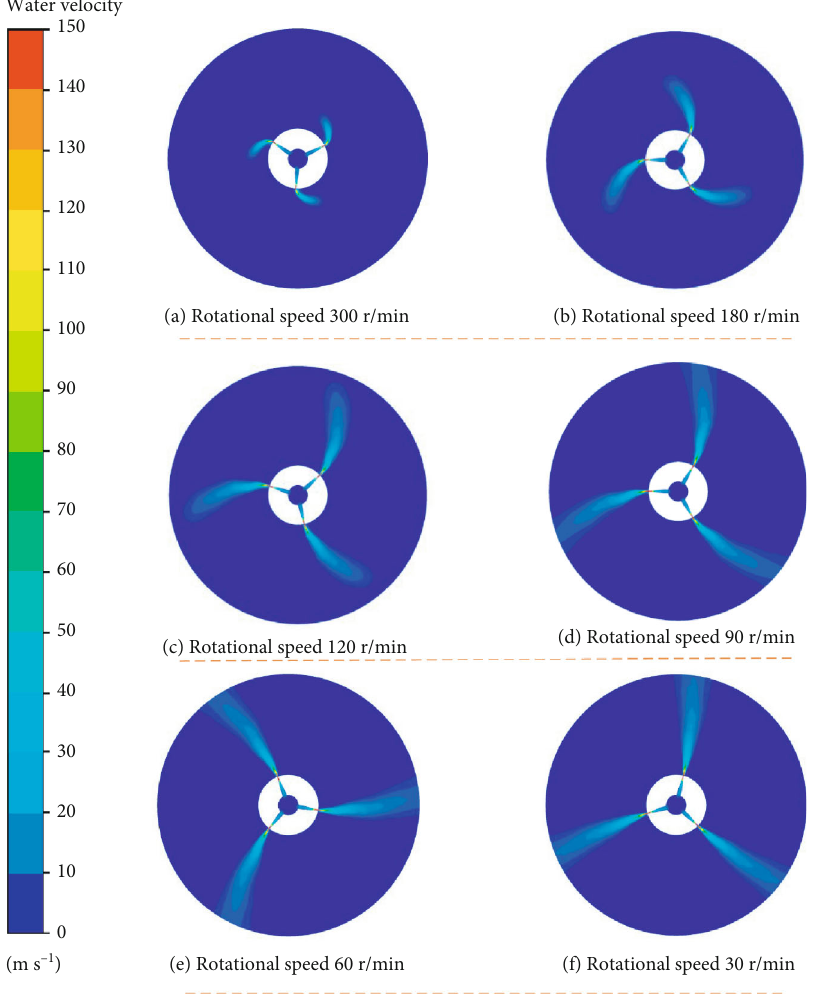
Figure 18: Contour maps of jet velocity for the three-nozzle combination at di ff erent